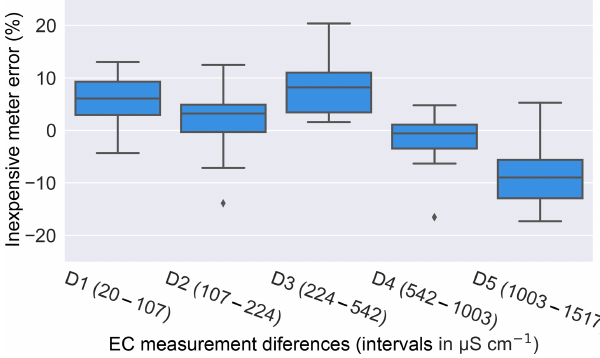
Figure 1. Box plots of inexpensive water quality tester (HoneFor- est) errors for five different intervals (i.e., D1 to D5). The ranges of EC values from reference EC measurements (determined by a calibrated GHM 3431 (GHM-Greisinger) EC meter) are shown in parentheses in µScm − 1 . Boxes show the interquartile range be- tween the first and third quartiles of the dataset, while whiskers extend to show minimum and maximum values of the distribution, except for points that are determined to be outliers (shown as dia- monds), which are more than 1.5 times the interquartile range away from the first or third